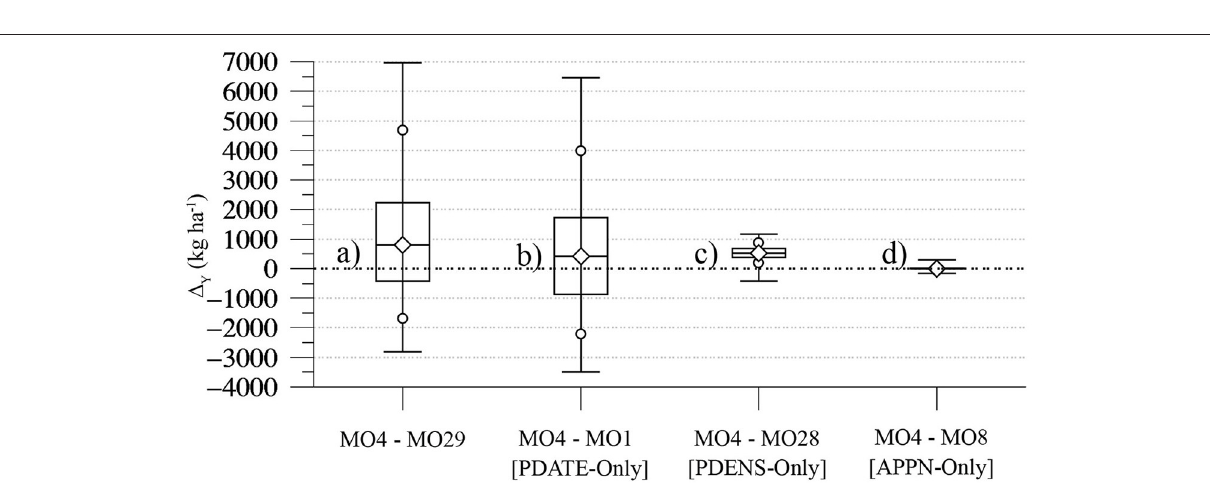
FIGURE 5 | (a) Distribution of yield effect ( 1 Y ) values resulting from subtracting grain yields generated via the MO 29 management option from the yield generated via the MO 4 option using the same station-year’s weather data. (b) As in (a) for 1 Y values generated by subtracting MO 1 from MO 4 yields. (c) As in (a) for 1 Y values generated by subtracting MO 28 from MO 4 yields. (d) As in (a) for 1 Y values generated by subtracting MO 8 from MO 4 yields.